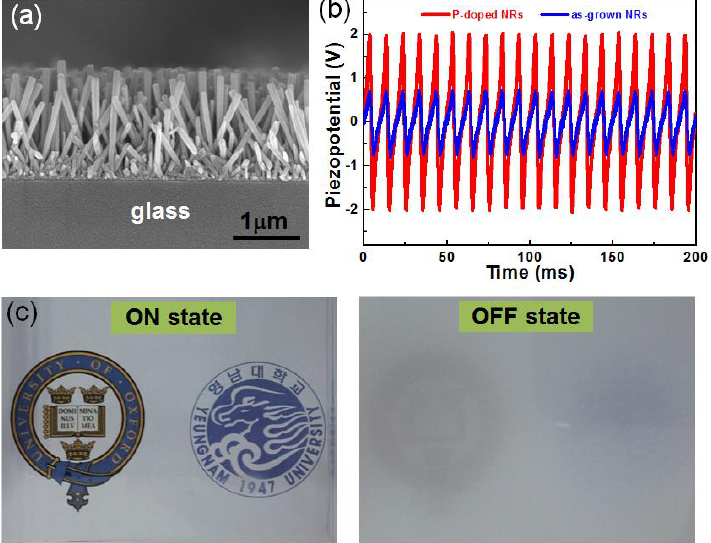
Figure 9. ( a ) SEM images of p-type ZnO:P nanorods on a glass substrate; ( b ) the piezoelectric output potential measured from sound-driven piezoelectric nanogenerators (SPNGs) consisting of ITO-coated flexible polyethylene terephthalate (PET) as a top electrode and ZnO nanorods before and after P-doping; ( c ) a polymer-dispersed LC (PDLC) device (4 cm × 5 cm) switched on ( left ) by an SPNG and ( right ) before being switched on using an SPNG, respectively. Reprinted with permission from [27]. Copyright 2014, Royal Society of